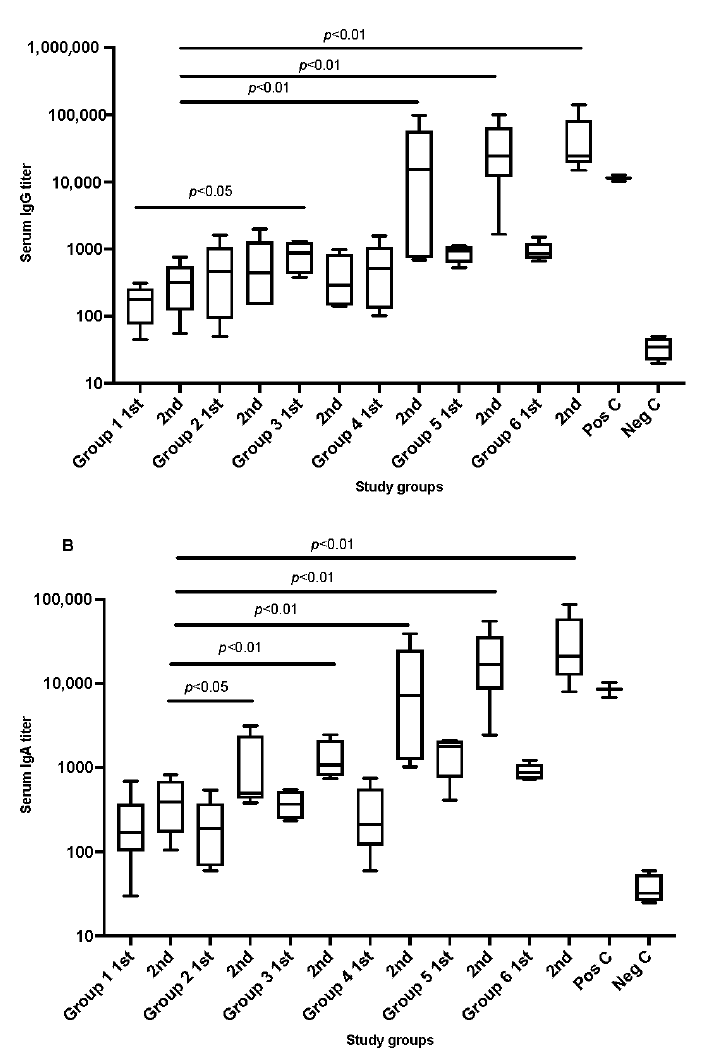
Figure 1. Graphs ( A , B ) shows the serum antibodies titration IgG and IgA, respectively, in immunized mice after administrating SARS-CoV-2 recombinant antigens in formulated vaccines. Serum was collected from each tested mouse group in week 3 and week 7 after administrating the recombinant proteins to the animals. Pos C is positive control and Neg C is the negative control group. Data are driven from 5 individuals per group, p value <